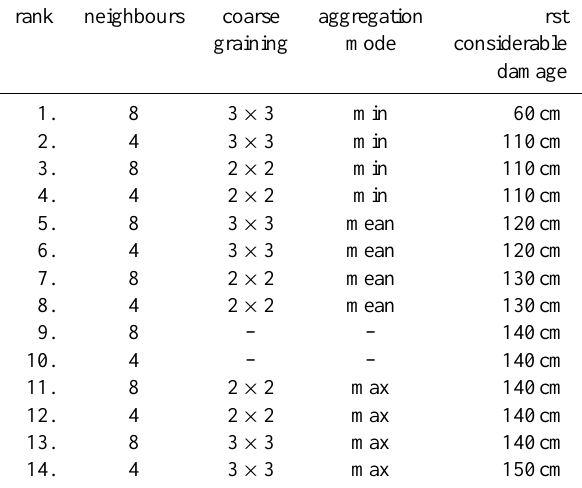
Table 1. Overview of the explored inundation determination modes sorted by the estimated damage (high damage from top) along with the lowest water level, for which a considerable damage (over 1 mil- lion DKK) is found (last column). The options differ in the number of nearest neighbours considered (2nd column), the coarse-graining (3rd column), and the value associated to the coarse-grained cells (4th column), see Sect. 3.